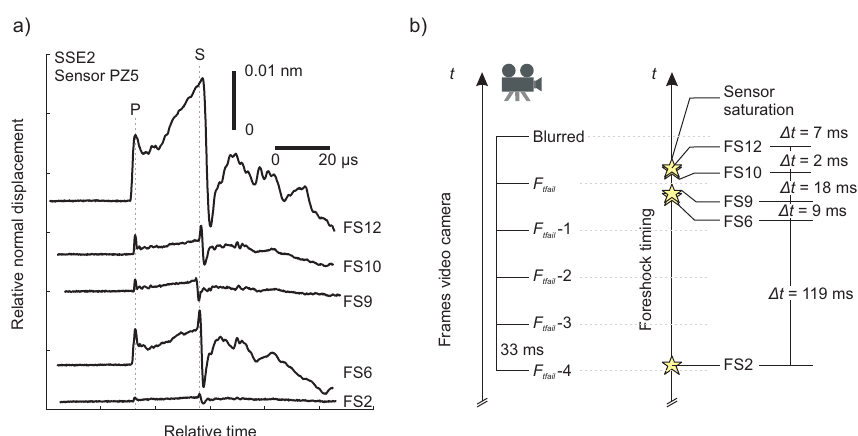
Figure 14. ( a ) AE signals from PZ5 for five foreshocks in the SS2 sequence, which were located in the field of view of the camera; ( b ) the left-hand side shows a schematic of the frame separation of the camera along time in the y -direction. Foreshocks shown in (a) are placed on the time axis on the right-hand side. Changes in light intensity due to foreshocks between frames allowed us to initialize the timing of the